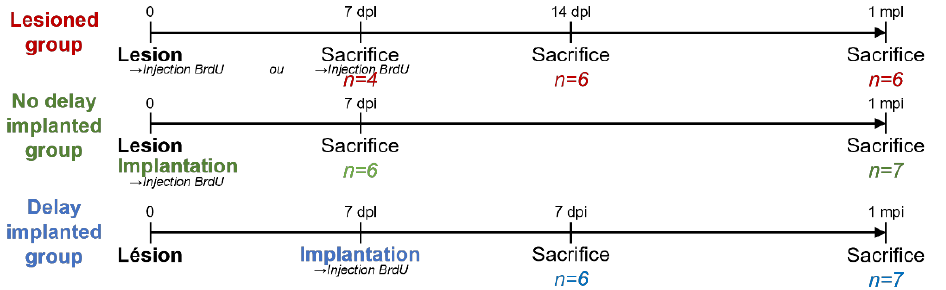
Figure 1. Timeline of the study representing the different groups and the different time points of mice hydrogel implantation and sacrifice. dpl: days post-lesion; mpl: month post-lesion, dpi: days post-implantation, mpi: month post-implantation.